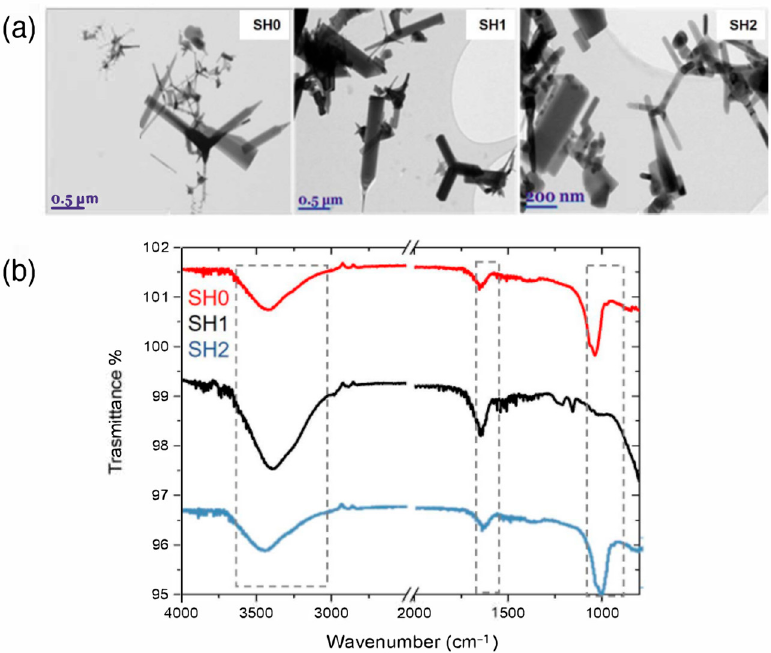
Figure 1. Morphological and chemical characterization of SH0, SH1, and SH2 ZnO-T samples. ( a ) TEM images showing the characteristic tetrahedral structure of ZnO-Ts. ( b ) ATR-FTIR spectra. Table 1. Hydrodynamic diameter (size), polydispersity index (PdI), and surface charge (zeta potential) of ZnO-T samples obtained by DLS measurements. The analyses were performed in ultra- pure water (pH 7).